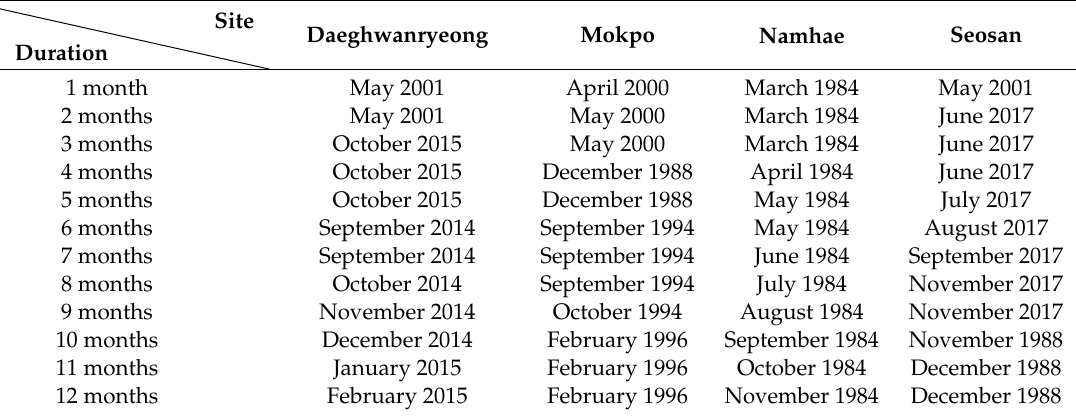
Table 2. Date when the most extreme drought index